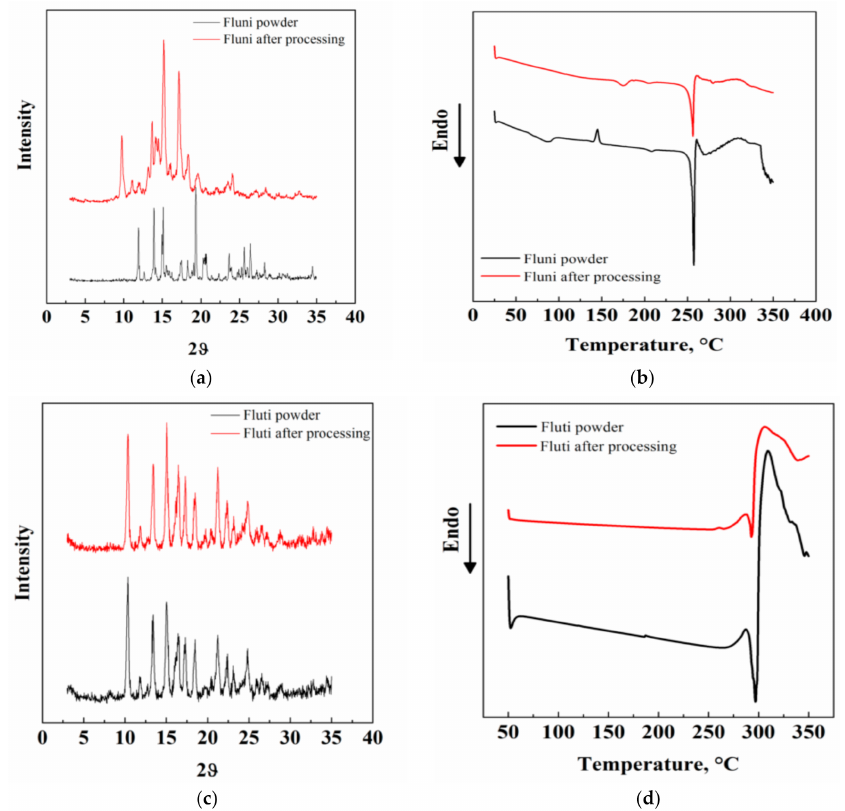
Figure 8. Fluni XRD patterns before and after the supercritical extraction in ( a ); Fluni DSC thermograms before and after the supercritical extraction in ( b ); Fluti XRD patterns before and after the supercritical extraction in ( c ); Fluti DSC thermograms before and after the supercritical extraction in ( d